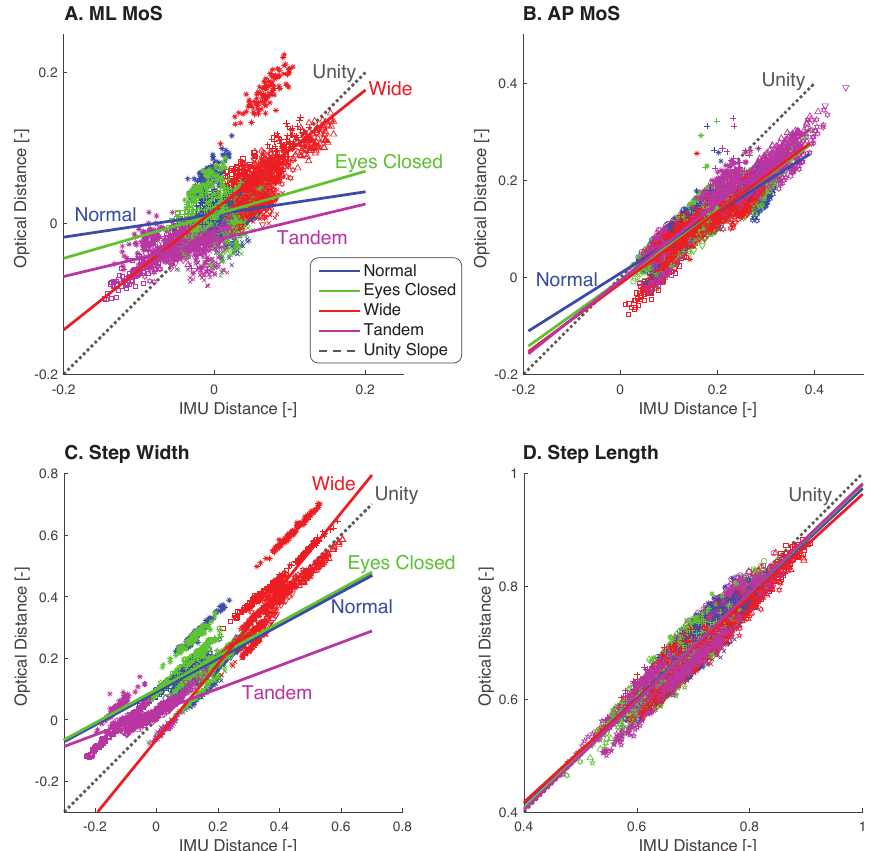
Figure 5. Minimum MoS and step-placement measures with Optical plotted against IMU. Visual- ization of intraclass correlation (ICC) for ( A ) minimum ML MoS, ( B ) minimum AP MoS, ( C ) step width, and ( D ) step length. Each data point represents an individual gait cycle from each participant ( N = 10) for all four conditions (Normal—blue, Eyes Closed—green, Wide—red, Tandem—magenta). Linear fits were performed for each condition (solid lines) with perfect agreement indicated by the unity slope (dotted